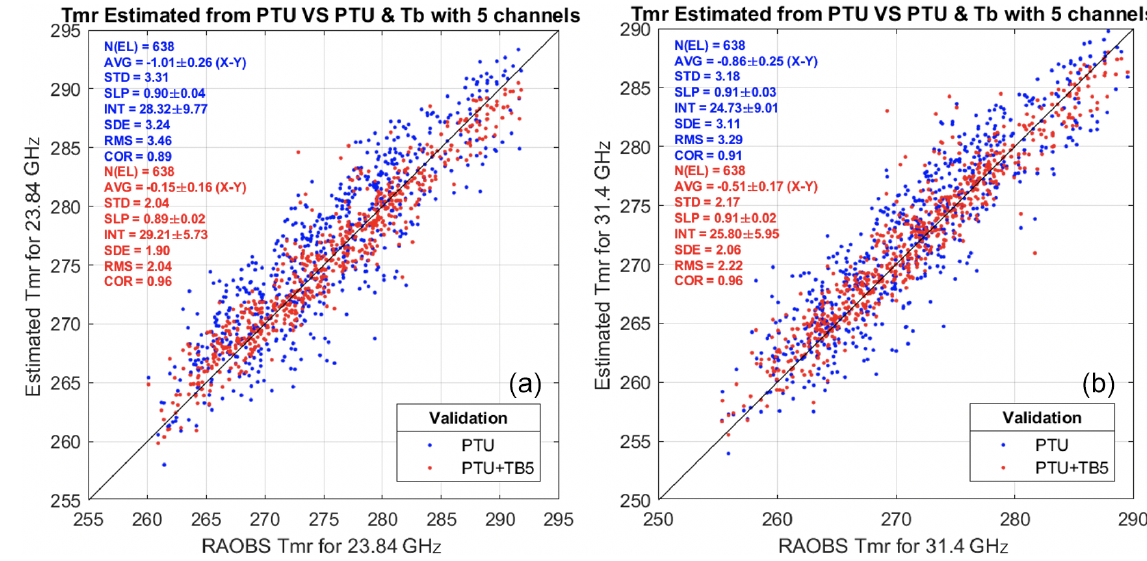
Figure 3. Estimated vs. reference T MR at K band: (a) 23.84GHz and (b) 31.4GHz. Red dots indicate estimated T MR based on PTU and T B , while blue dots indicate T MR based on PTU only. Each panel reports the number of elements ( N( EL)), the average difference (AVG), the standard deviation (SD), the slope (SLP) and intercept (INT) of a linear fit, the standard error (SE), the root mean square difference (RMSD), and the correlation coefficient (COR); 95% confidence intervals are given for AVG, SLP, and INT. Units for AVG, SD, SE, and RMSD are